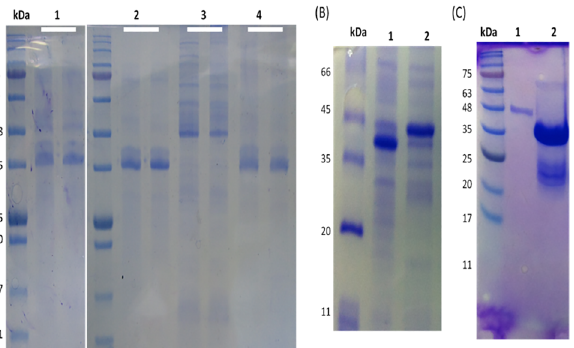
Fig 3. Purification of inclusion bodies by solubilization and refolding in alkaline-based buffer containing redox agents. A) Semi-solubilization of inclusion bodies in dH 2 O (pH 12) after 10 min of incubation. L1, the isolated inclusion bodies; L2, purified protein (final product); L3, removing of host cell proteins; L4, remaining insoluble aggregates after final solubilization (each line duplicated). B) Refolding of soluble protein in buffer containing oxidized and reduced glutathione to reform the disulphide bridges of TACH. The refolded protein showed different levels under reducing and non-reducing conditions of the SDS-PAGE, indicating the formation of disulphide bridges. C) SDS-PAGE analysis of the fusion protein. L1, a single band at the expected size for the monomer. L2, double bands of the fusion protein. The upper faint band at the dimer size and the lower thick band at the monomer size